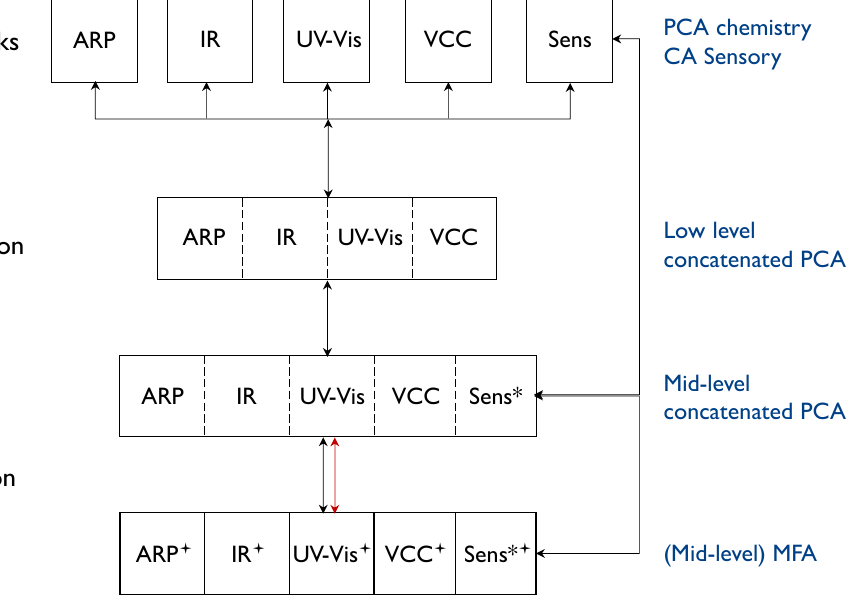
Figure 1. Structure of the data fusion strategy and model comparisons. Black arrows indicate the pairs used for RV coefficient calculation and the red arrow indicates iTOP RV. *: the data block was pre-processed, (cid:70) : the data block was weighed. Abbreviations and further details are provided in text.